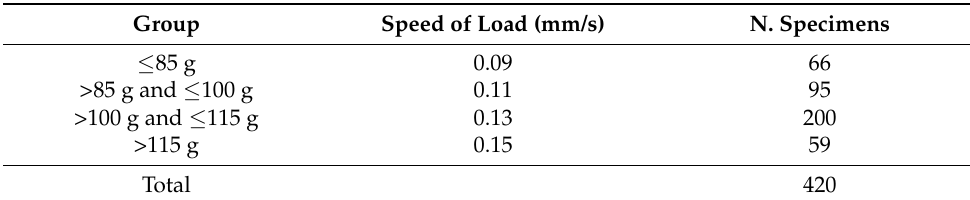
Table 2. The division of the sample into groups for the bending tests. Group Speed of Load (mm/s) N.